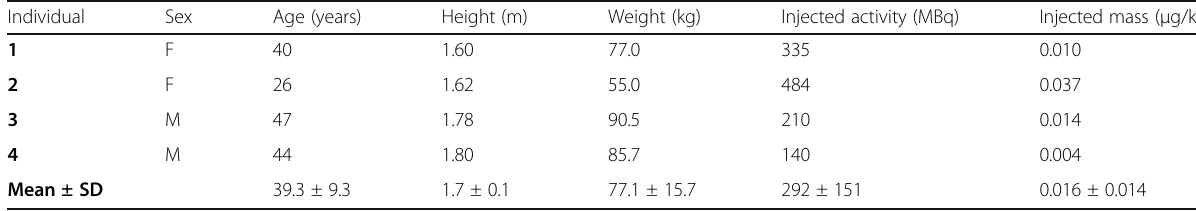
Table 1 Demographic information, injected activity dose, and injected mass for each subject ( n = 4) Individual Sex Age (years) Height (m) Weight (kg) Injected activity